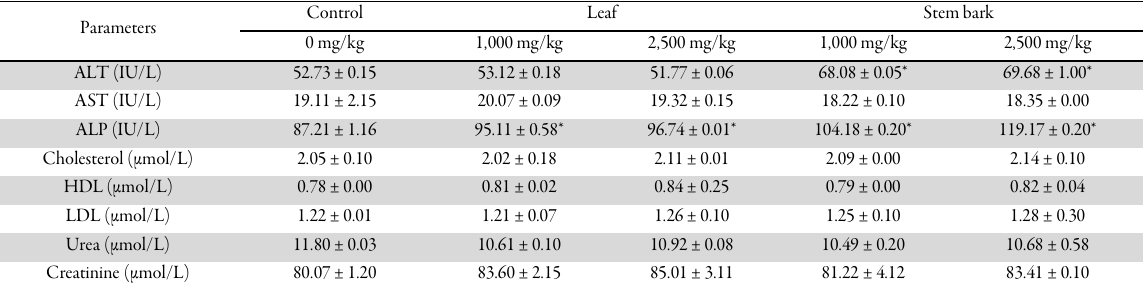
Table 4. The effect of leaf and stem bark extract of Cola millenii on serum biochemical parameters of rats